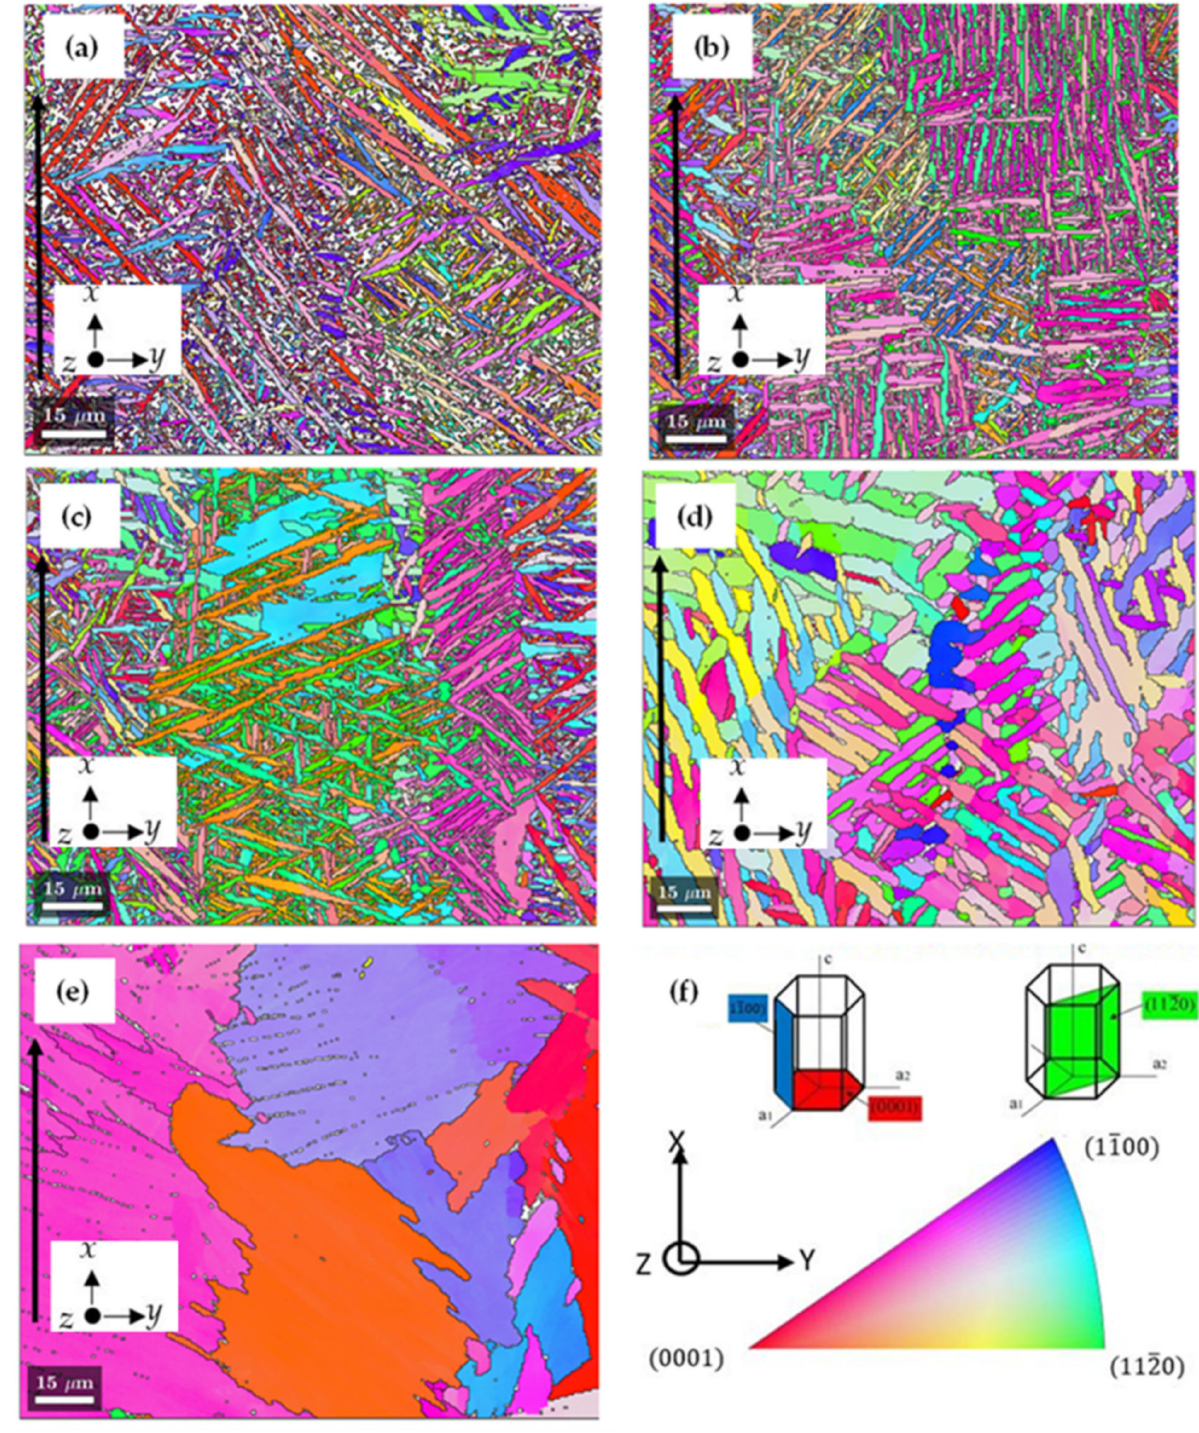
Figure 4. The orientation distribution of ( a ) samples A, ( b ) samples B, ( c ) samples C, ( d ) samples D and ( e ) samples E, and α - hcp critical planes and their depiction in IPF key ( f ). The black arrows in these micrographs indicate the build